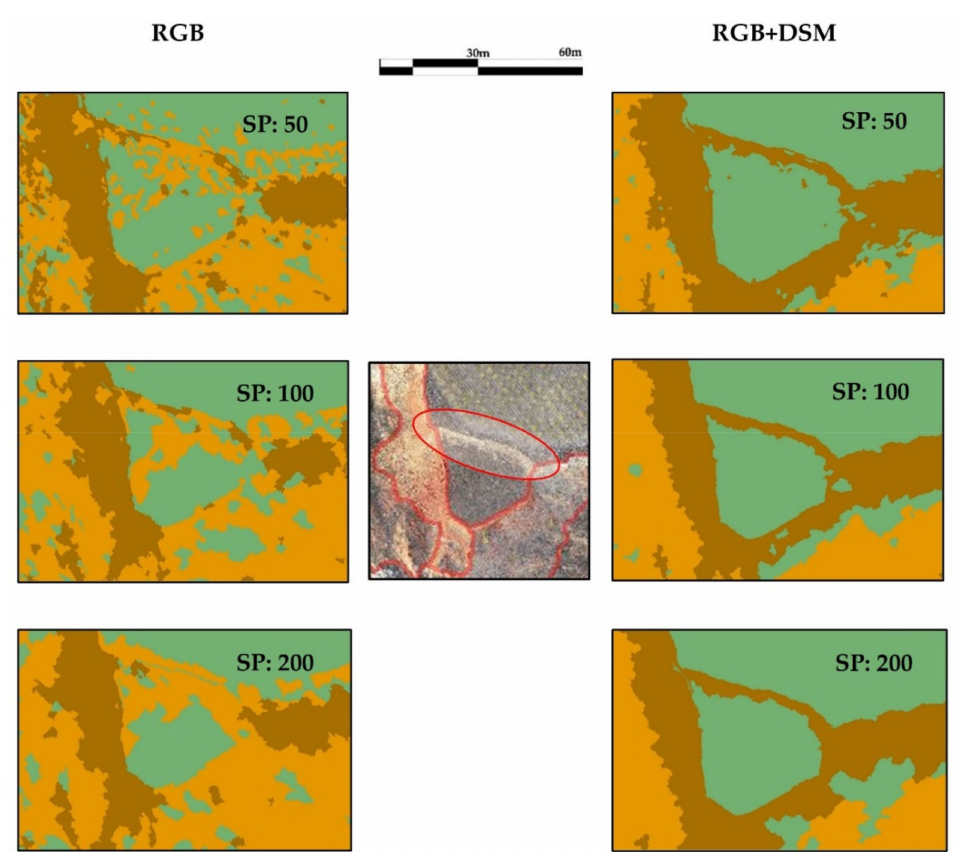
Figure 10. Classification close-up for three different SPs using the RGB and RGB+DSM input structures (green: non-affected, dark brown: scarp, light brown: depletion). The reference dataset is illustrated in the middle.